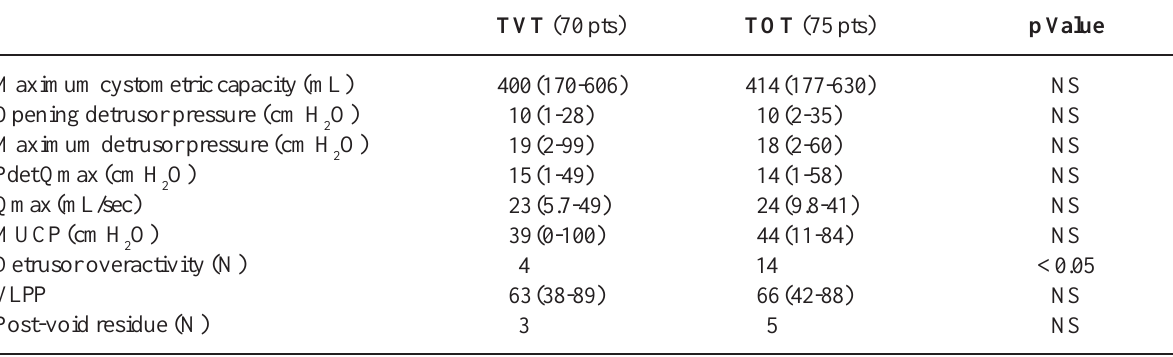
Table 2 – Preoperative urodynamic values (median and